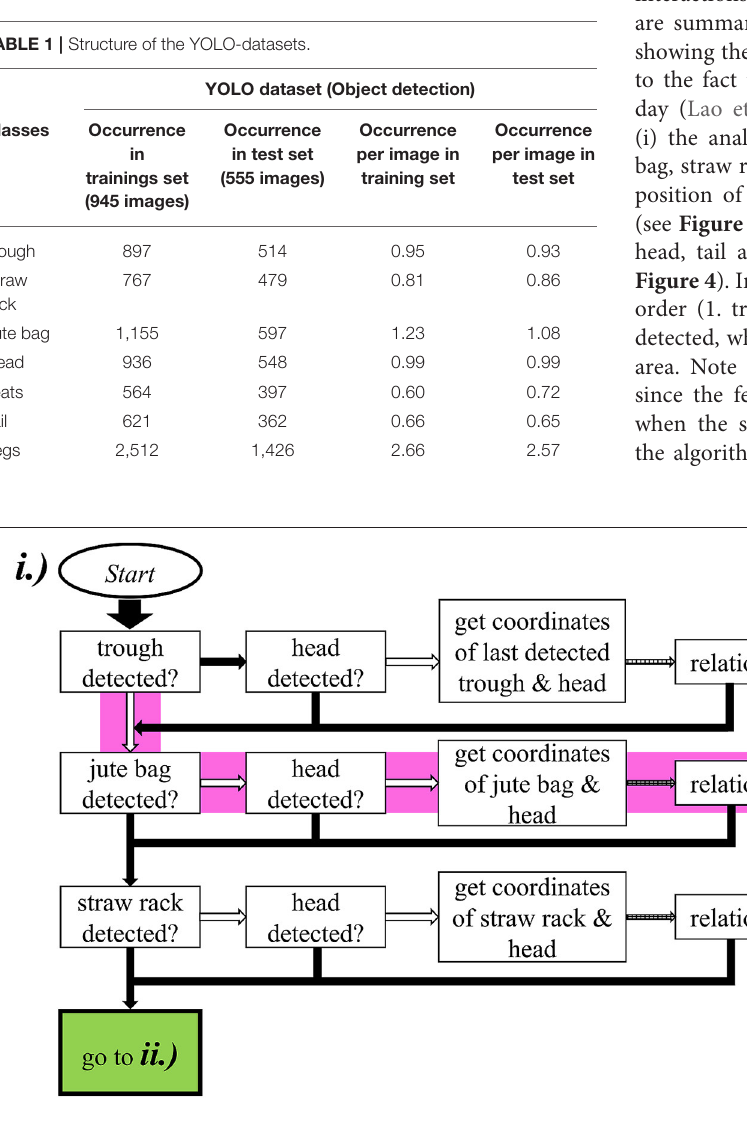
FIGURE 3 | Illustration of the hierarchical conditional statement for classification of interactions (eating/drinking with the trough or nest-building-behavior (NBB) with jute bag or straw rack). White arrow means “yes,” black arrow “no” and striped arrows are highlighting calculation-/threshold-steps. The pink highlighted path is an example of the situations in Figure 8C (interaction with jute bag and Figure 8E (interaction with jute bag classified, although the sow is actually lying with a displaced jute bag).